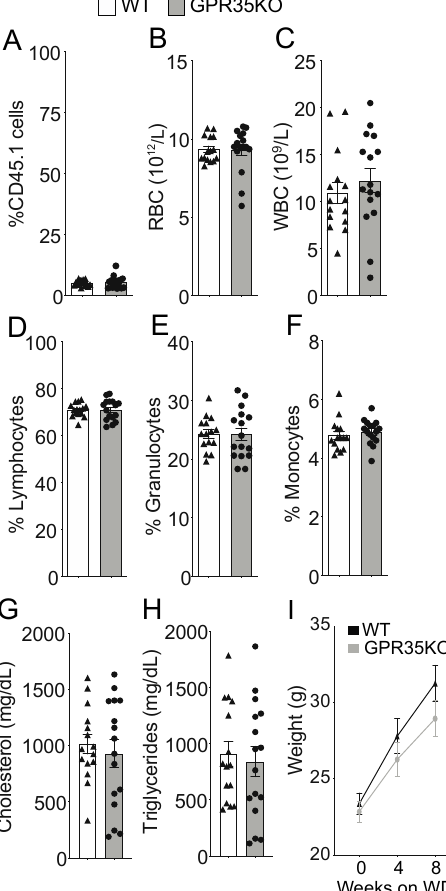
Figure 1. GPR35KO and WT LdlrKO chimeric mice present similar blood parameters and body weight. Thirteen week-old LdlrKO mice (expressing the CD45.1 allele) were irradiated and ran- domly assigned to receive CD45.2 allele expressing bone marrows from GPR35KO mice ( n = 16; 8 females + 8 males) or WT mice ( n = 15; 8 females + 7 males). After recovering for 4 weeks, mice were fed WD for 8 weeks. ( A ) Percentage of remaining host CD45.1+ cells in blood at the end of experiment (note: non-irradiated LdlrKO mice present 100% CD45.1+ cells). ( B – F ) Differential blood counts of ( B ) red blood cells (RBC), ( C ) white blood cells (WBC), ( D ) % of lymphocytes, ( E ) % of granulocytes, and ( F ) % of monocytes. ( G ) and ( H ) show plasma cholesterol and triglyceride levels. ( I ) Weight gain during the 8 weeks of WD feeding. Results are mean ± SEM. Pooled data is shown. No significant differences were observed ( A – H , Mann–Whitney; I , Two-way ANOVA).